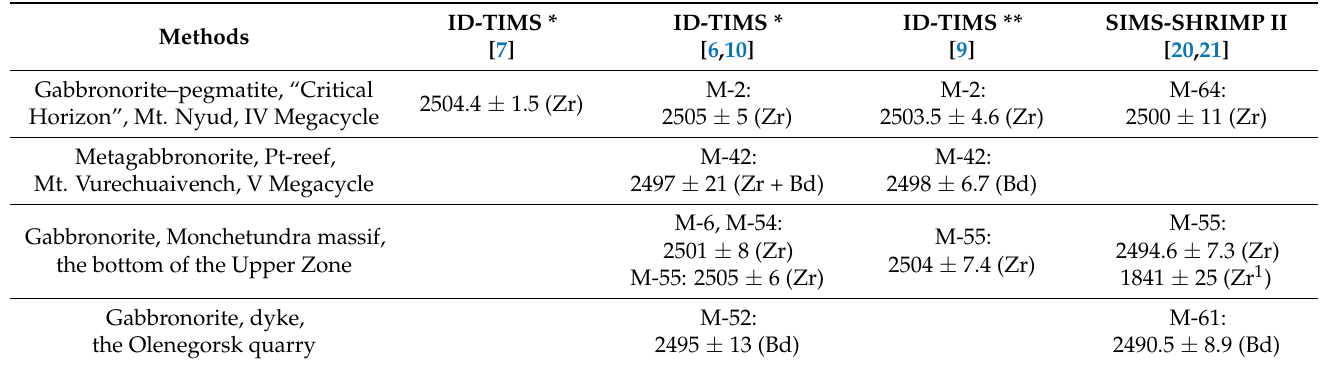
Table 2. Data on isotope analysis of zircon and baddeleyite from the rocks of the Monchepluton, Monchetundra massif, and